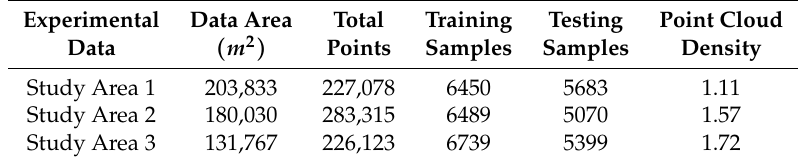
Figure 2. Original data of the three study areas. Table 2. Experimental data